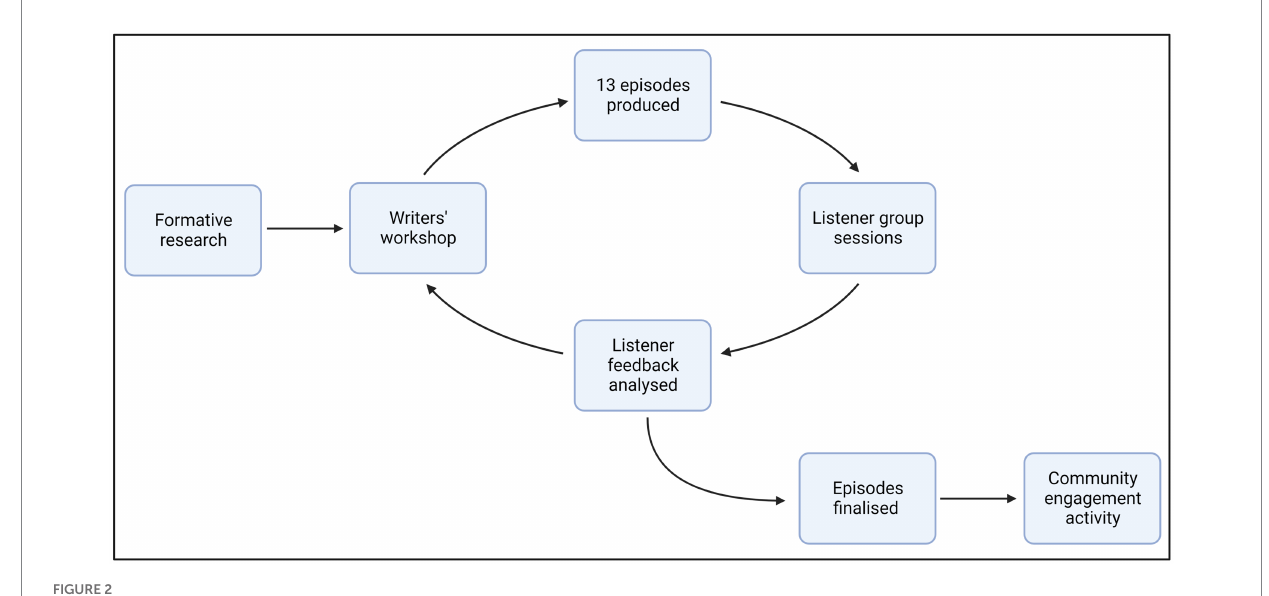
FIGURE 2 Iterative radio drama development